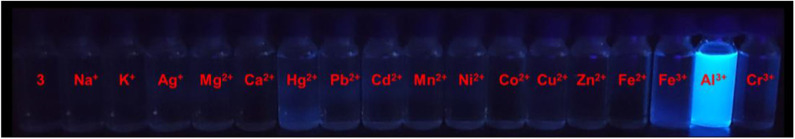
Fluorescence photo of 3 (1 μM) and 3 with metal ions (1 μM) (Na+, K+, Ag+, Mg2+, Ca2+, Hg2+, Pb2+, Cd2+, Mn2+, Ni2+, Co2+, Cu2+, Zn2+, Fe2+, Fe3+, Cr3+, and Al3+) under the irradiation of an 365 nm UV lamp.